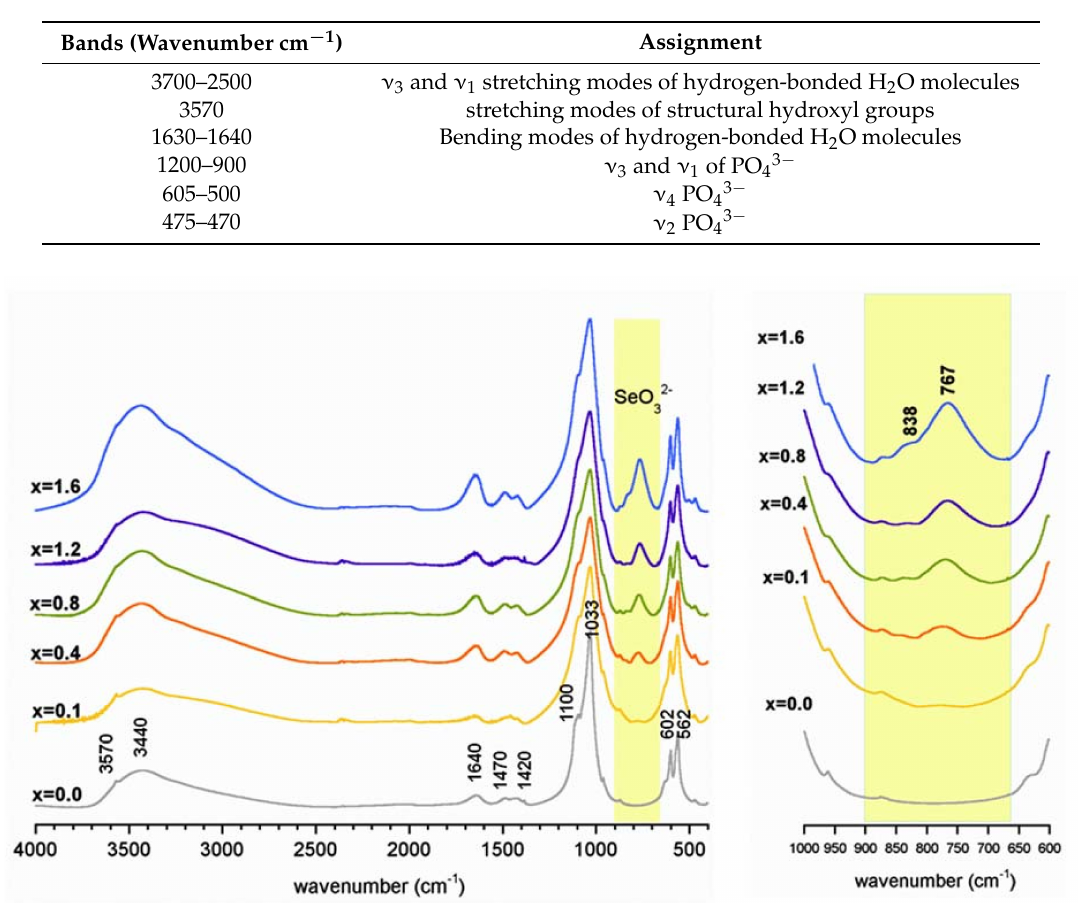
Figure 5. The FT-IR transmission spectra of the studied selenite-doped HA (HA- x SeO 3 ) and HA undoped. Reprinted from [43] with permission from